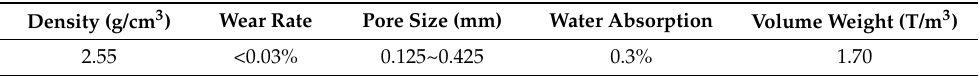
Table 1. The physical characteristics of natural zeolite.